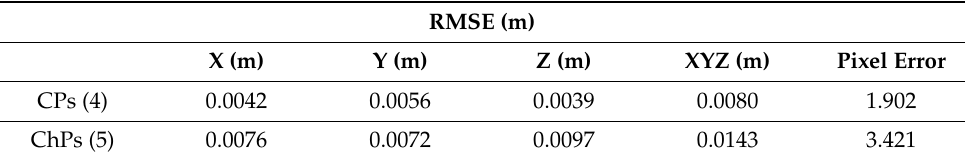
Table 5. RMSE of the CPs and ChPs for the orientation of all image files. RMSE (m) X (m)